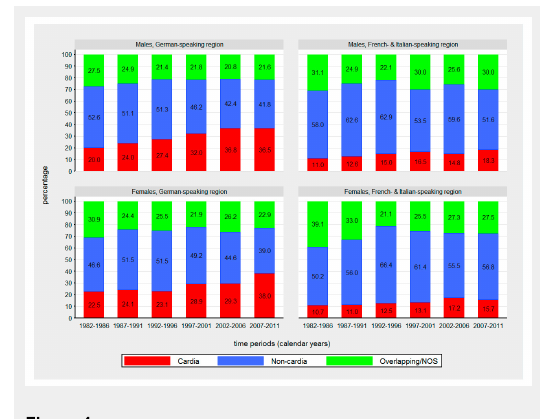
Figure 4 Time trends in proportions of gastric cancer cases by sex, anatomical location and language region from 1982 to 2011. NOS = not otherwise specified